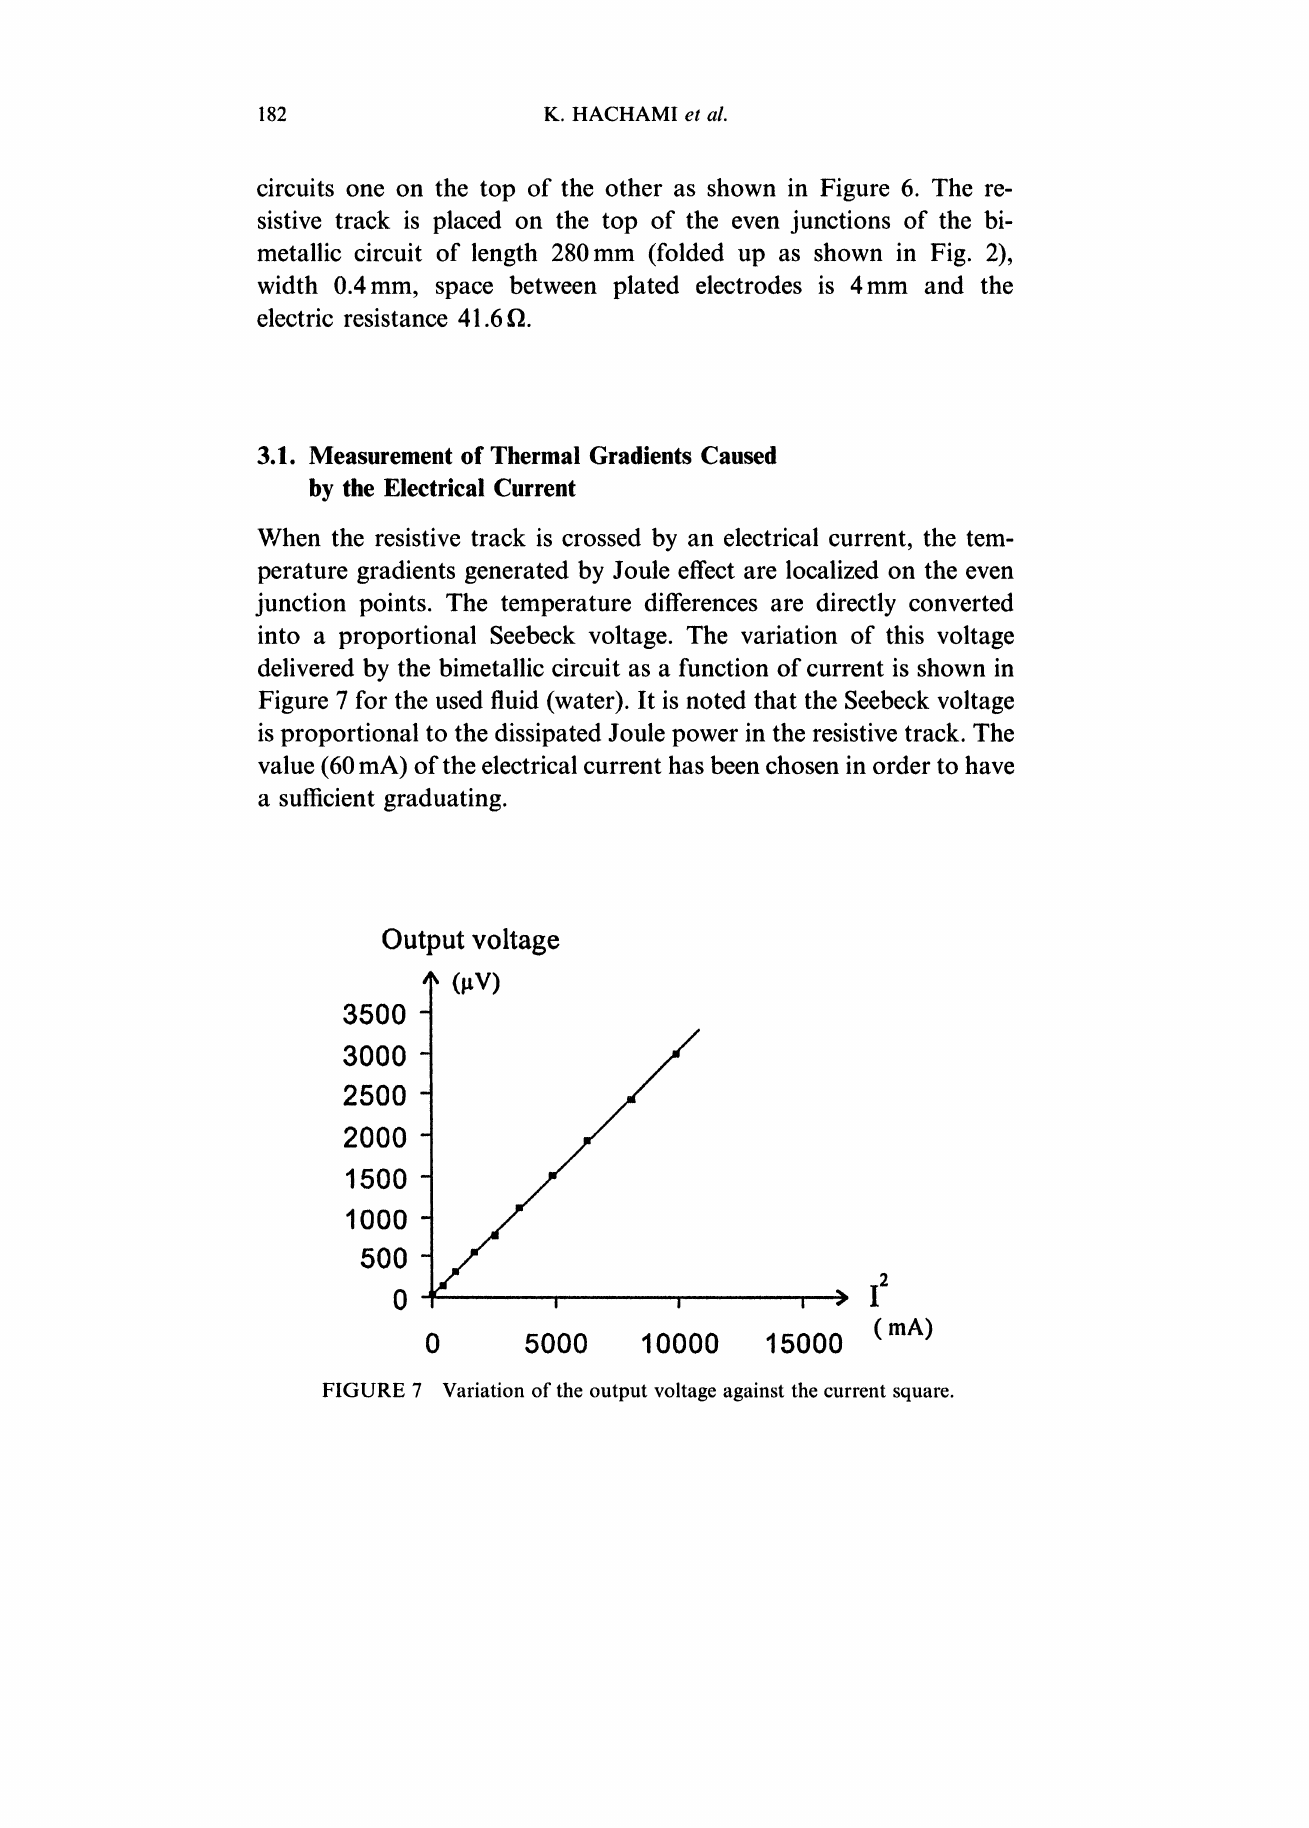
FIGURE 7 Variation of the output voltage against the current